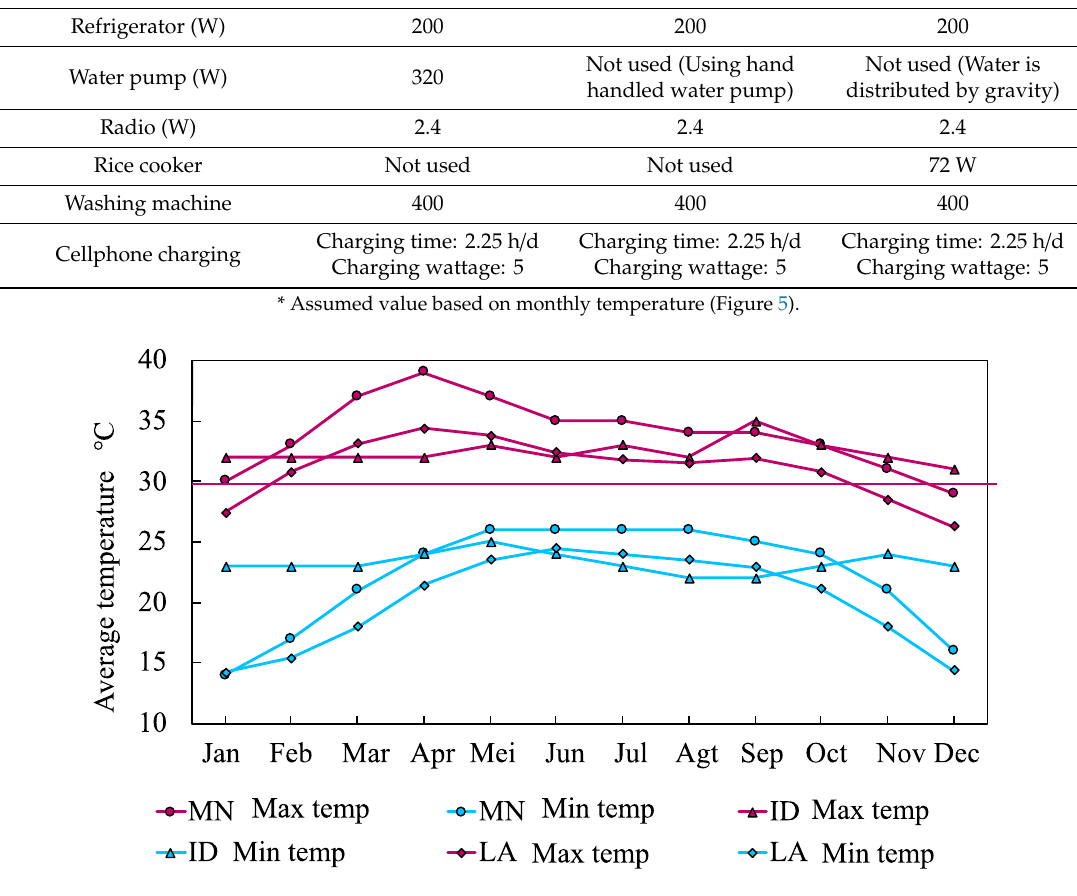
Figure 5. Monthly average temperature in each case study village, constructed from Merra-2 data